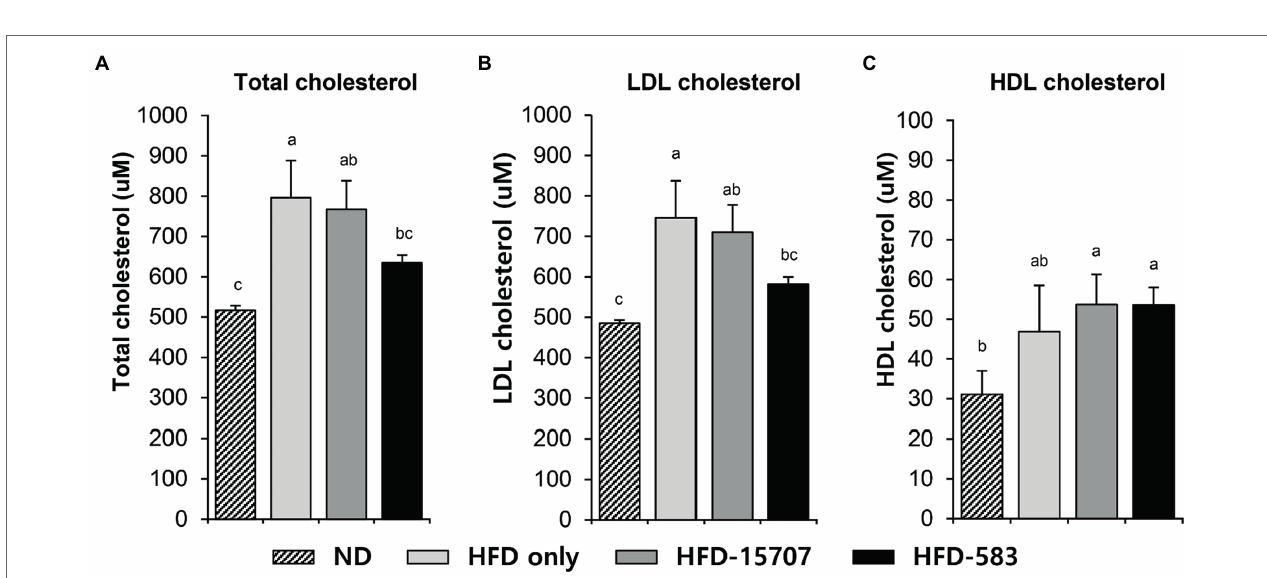
FIGURE 4 | Cholesterol levels in serum samples of four groups after 9 weeks. (A) Total cholesterol level, (B) LDL cholesterol level, and (C) HDL cholesterol level in serum. Differential letters indicate statistically relevant differences among the different groups ( p <